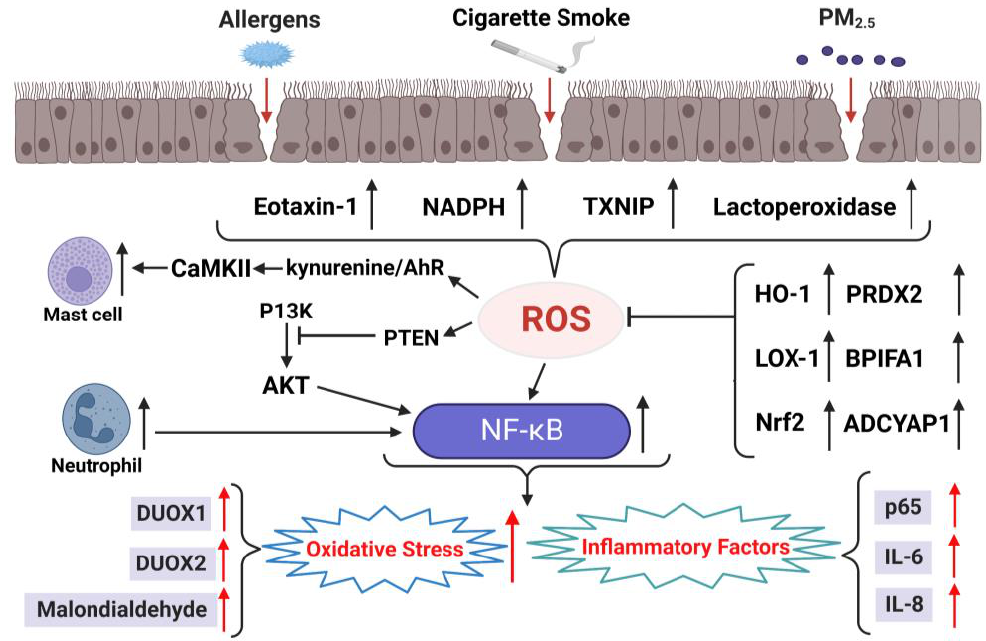
Figure 2. Role of oxidative stress in CRSwNP. ROS cause neutrophil activation, which can upregulate the expression of genes to release their corresponding proteins. Many of these genes depend on the activation of transcription factors, such as NF-κB, to induce expression. NF-κB activation may be the basis for the effect of pro-inflammatory stimulation of human neutrophil gene expression [87]. The growth of NPs is also closely related to the effects of various cytokines [88], and NF-κB is one of the most important factors related to the production of cytokines during inflammation. One study analyzed the expression of NF-κB, associated inflammatory cytokines, and adhesion molecules in patients with CRSwNP [89]. NPs of a CRSwNP group possessed a significantly higher number of NF-κB p65-positive cells and higher mRNA expression levels of IL-6, IL-8, and eotaxin than uncinate tissues of the control and CRSsNP groups. Nrf2 acts as the key regulator of oxidation and environmental stress by translocating to the cell nucleus and promoting the expression of genes that produce a cell protective response [90]. Nasal sinus mucosal barrier function and tight junctions that had been destroyed by particulate matter could be restored via Nrf2 administration, indicating that activation of the Nrf2 pathway may be a potential therapeutic target for CRS [91]. Another study also showed that the barrier dysfunction of nasal sinus epithelial cells induced by cigarette smoke can be reversed through Nrf2 activation [92]. In addition to the above oxidative stress reactions related to CRSwNP, the following have been noted. Ca2+/calmodulin-dependent protein kinase II (CaMKII) is a multi- polymer serine-threonine kinase [93]. The normal activation of CaMKII triggers the exchange of subunits between these holoenzymes, but the increased activation of CaMKII via ROS [94,95] may lead to inflammation and other diseases. The kynurenine/AhR axis mediates mast cell activation through oxidative CaMKII in the pathogenesis of CRSwNP [96]. More in-depth research is needed to clarify the correlation between the kynurenine/AhR axis and CRSwNP-related oxidative stress. The mucosal surface is protected by many antibacterial factors, such as lactoperoxidase, which creates an inhibitory action on bacteria through the production of ROS [97]. Lactoperoxidase requires H 2 O 2 to oxidize thiocyanate, thus producing hypothiocyanite [98]. Another key process in epithelial defense is the regulation of dual oxygenase (DUOX) expression and function [99]. A study exploring the correlation between DUOX1 expression and inflammatory mediators in CRS [100] found that DUOX1